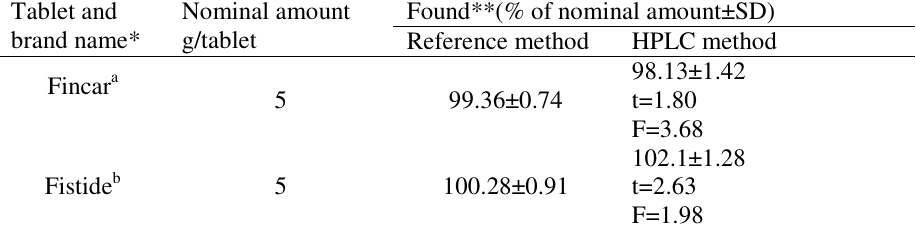
Table 3. Results of analysis of formulations containing